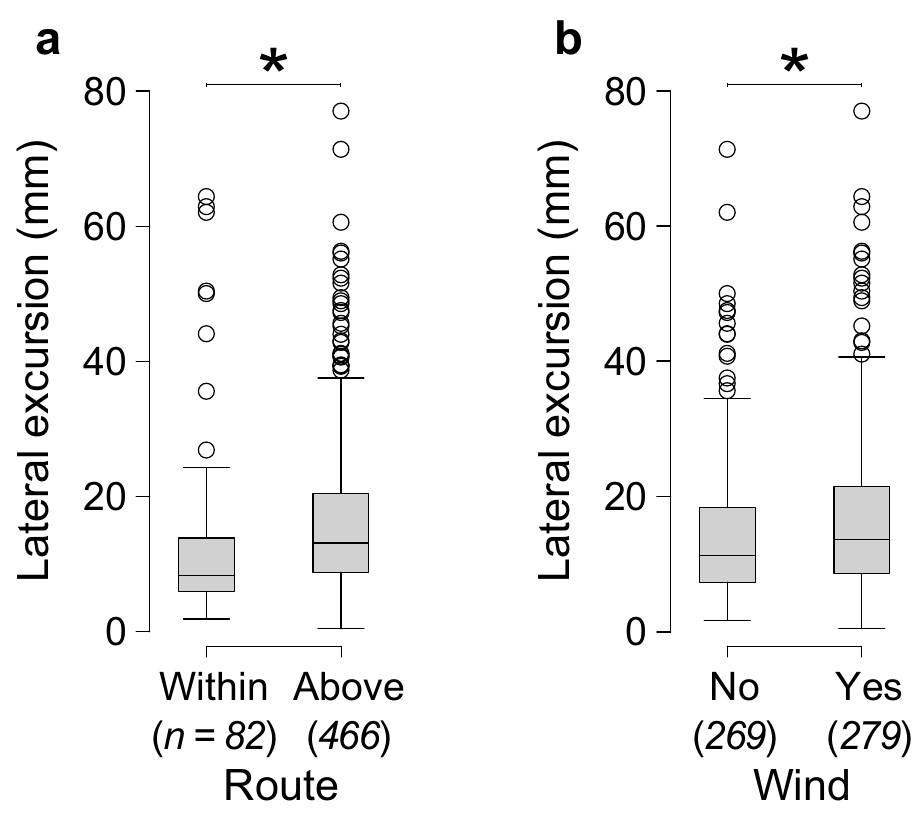
Fig 5. Effects of route and wind on lateral excursions of bees transiting the obstacle fields. Lateral excursions were (a) larger above versus within the obstacle fields and (b) larger in wind versus still air. Lines with asterisks indicate statistically different groups based on a linear mixed-effect model ( � P < 0.05). Italicized numbers below the x-axes labels show the sample size (number of flights) for each group.